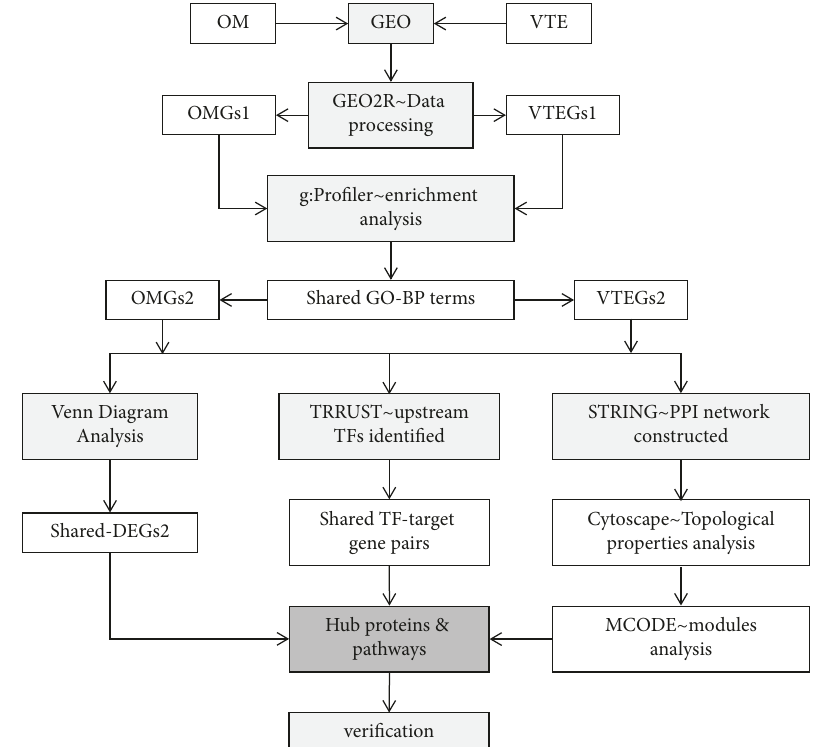
Figure 1: A flowchart of the present